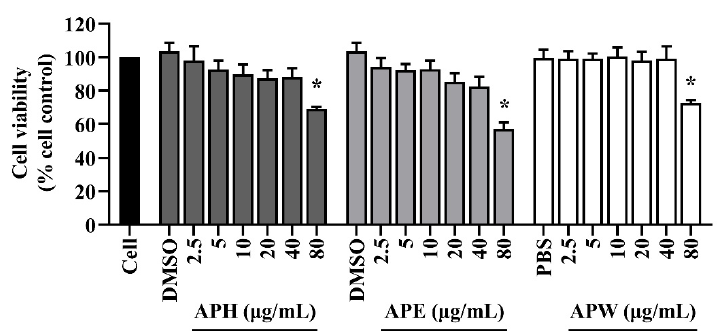
Figure 2. Cytotoxicity against HT-22 hippocampal cells of AP crude extracts: APH, APE, and APW for 24 h. DMSO (0.1%, v / v ) and PBS (0.1%, v / v ) were used as the vehicle control. All data are shown as the mean ± SEM of triplicate values. Statistical significance was analyzed by one-way ANOVA, Dunnett test. * p < 0.05 versus cell control.